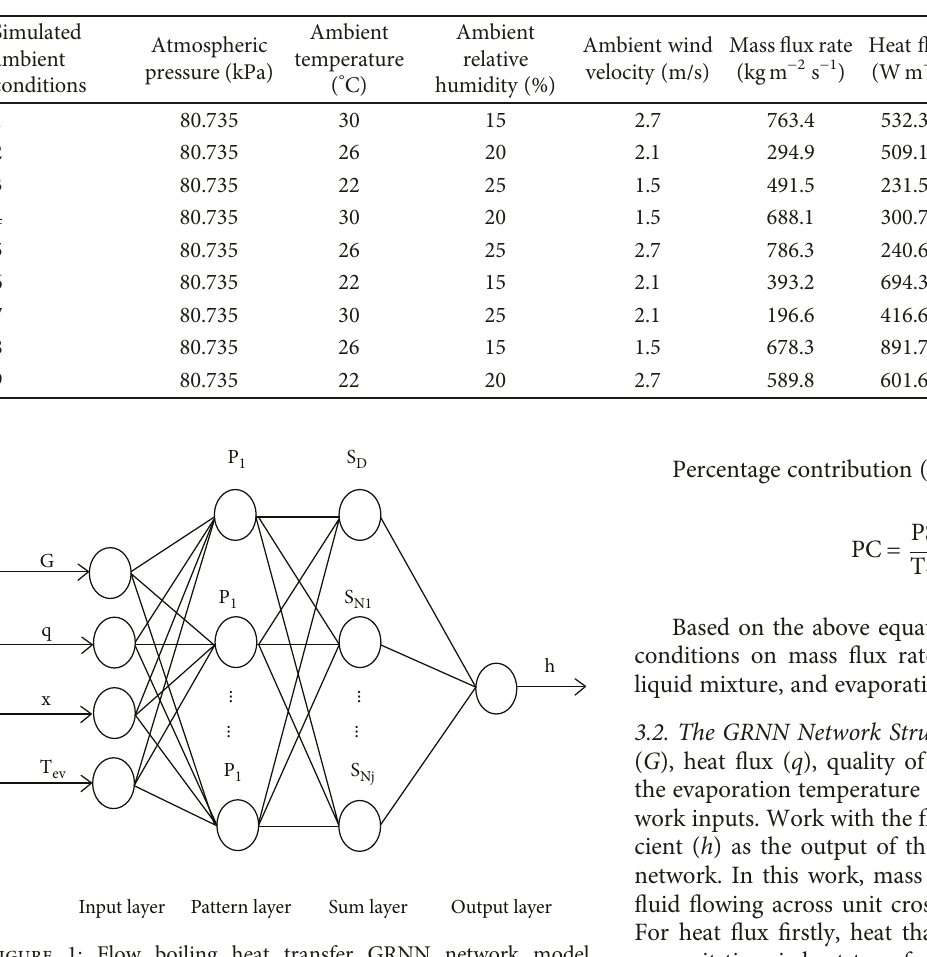
Table 3: Standard L orthogonal array of simulated ambient parameters and boiling heat transfer coe ffi cient. 9